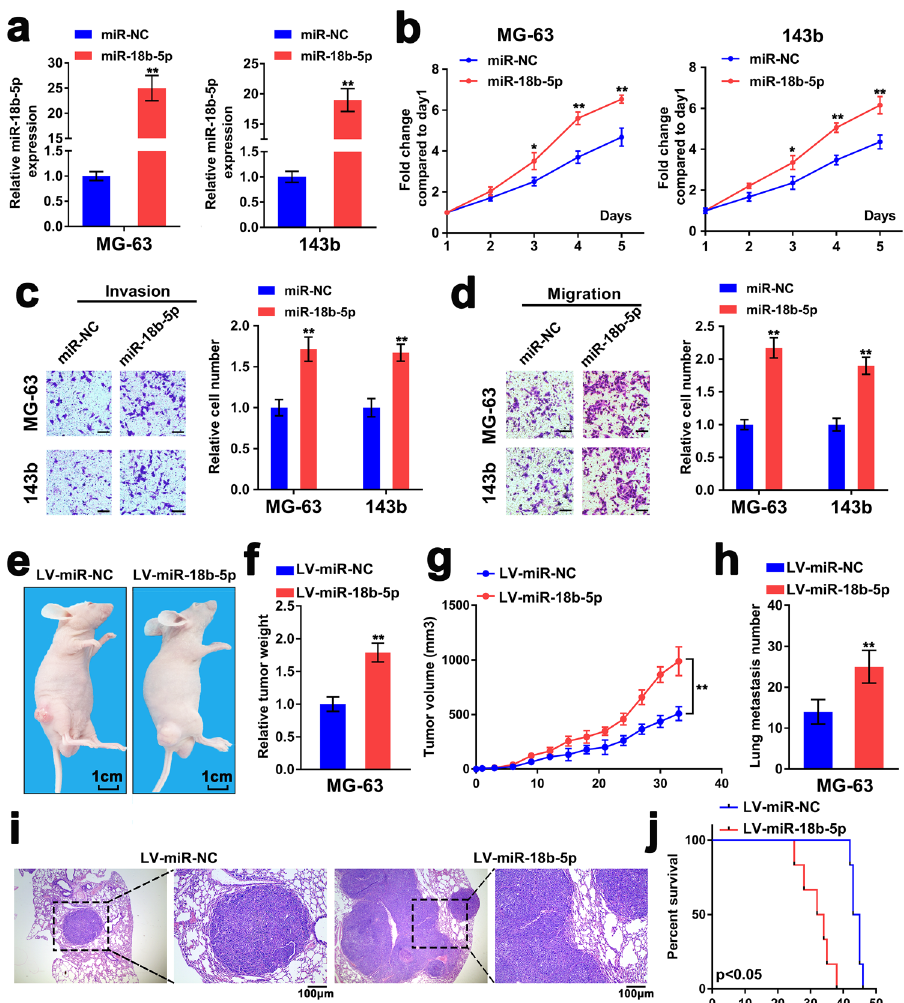
Figure 2. Upregulation of miR-18b-5p accelerates development of OS. ( a ) RT-qPCR was performed to detect miR-18b-5p expression in MG-63/143b cells transfected with miR-18b-5p mimic or miR-NC. ( b ) The cell viability of MG-63/143b cells was evaluated by the MTT method. ( c , d ) The capacity of invasion and migration of MG-63/143b cells was valuated by the transwell assay. Scale bar = 100 μm. ( e ) Xenograft tumor of nude mice subcutaneously injected with MG-63 with stably miR-18b-5p overexpression. ( f , g ) The weight and volume of xenograft tumor of nude mice. ( h – j ) The nude mice was injected with MG-63 with stably miR-18b-5p overexpression from tail vein. The number of lung metastasis of nude mice counted via H&E staining ( h ). The images of H&E staining of lung metastasis ( i ). The survival of nude mice was analyzed ( j